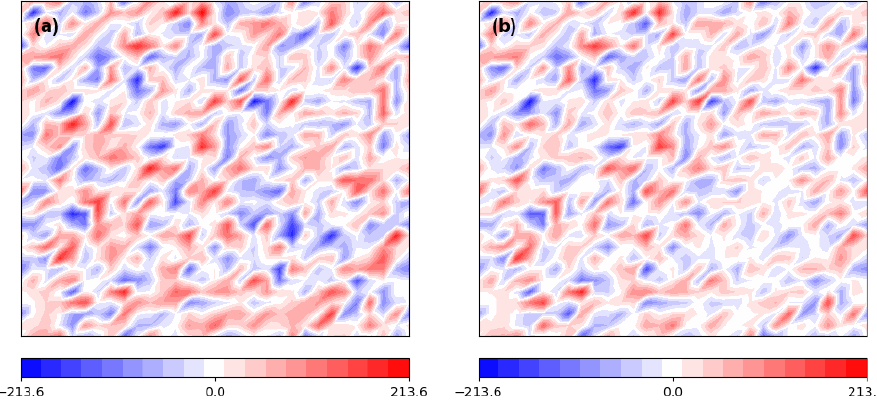
Figure 8. (a) A realization of the prior density of C for the γ 1 experiment. (b) A realization of the posterior density of C for the γ 1 experiment with mean c MAP removed. Note the difference in color map with Fig.